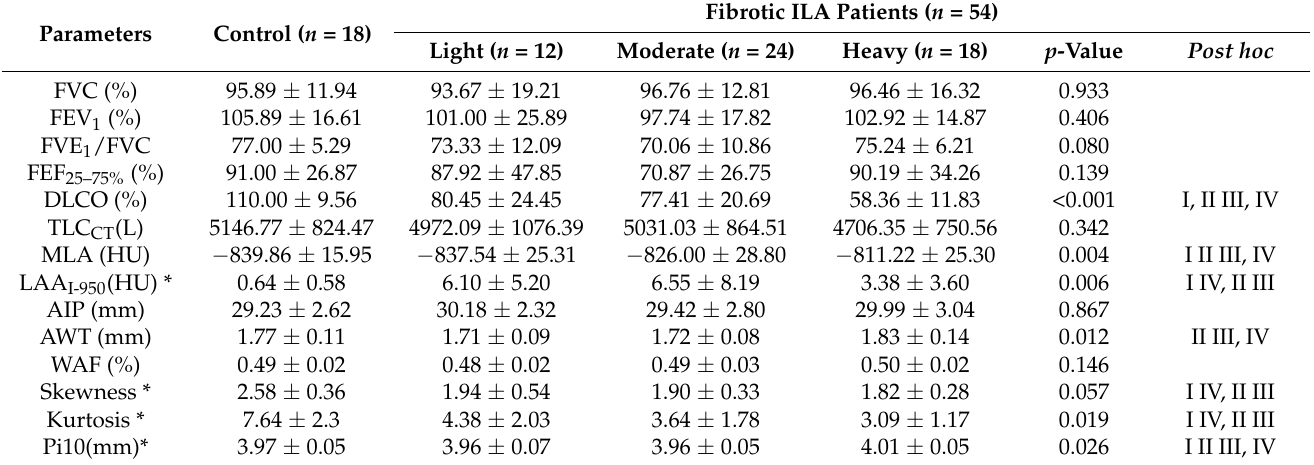
Table 2. Comparison of the Quantitative CT Measurements and Pulmonary Function Tests by Smoking Intensity in Fibrotic ILA patients.